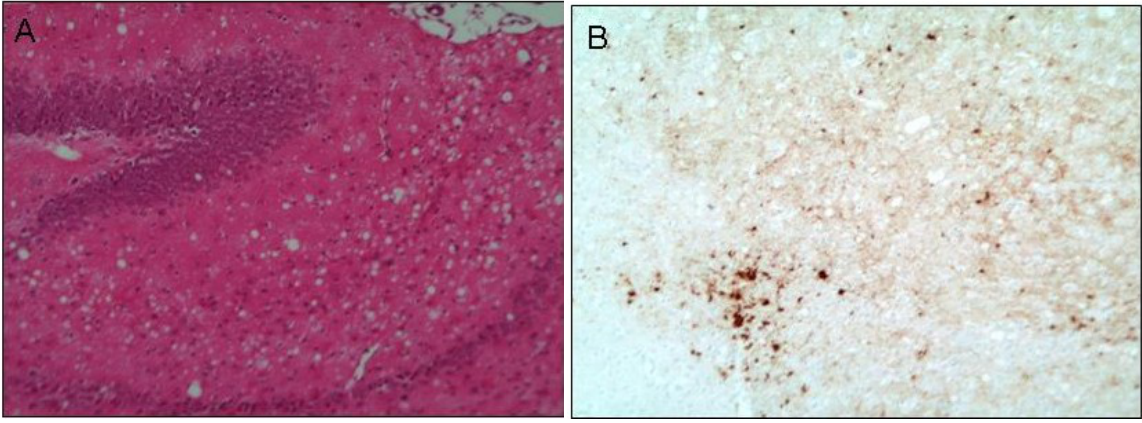
Figure 1. Histological examination of prion infected brain tissue. The micrograph in figure A displays the extensive vacuolation commonly referred to as spongy change, here observed at the terminal stage of prion disease. This is an example of diseased hippocampal tissue obtained from a mouse model of human prion (M1000) infection [17] stained with haematoxylin and eosin. Micrograph B shows the thalamic region, adjacent to the hippocampus, of these diseased mice depicting aggregates of prion protein in the form of plaques (dark brown deposits representing immunohistochemical detection of